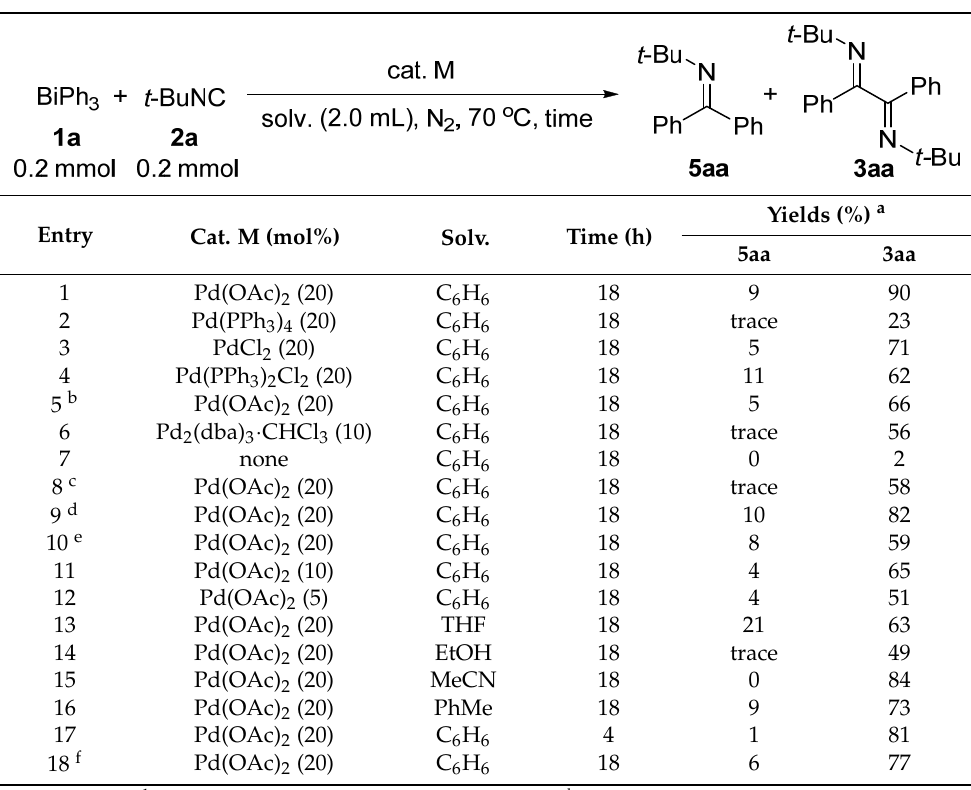
Table 1. Influence of reaction conditions on 5aa / 3aa selectivity.